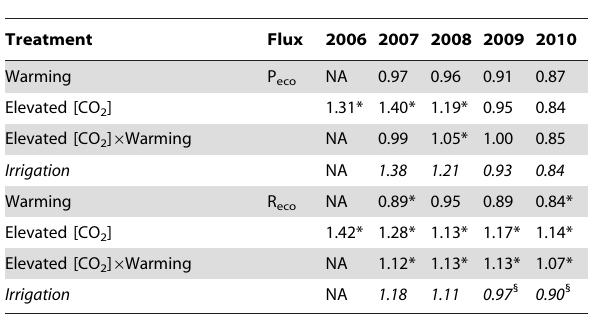
Table 1. Treatment effects on ecosystem CO 2 fluxes.